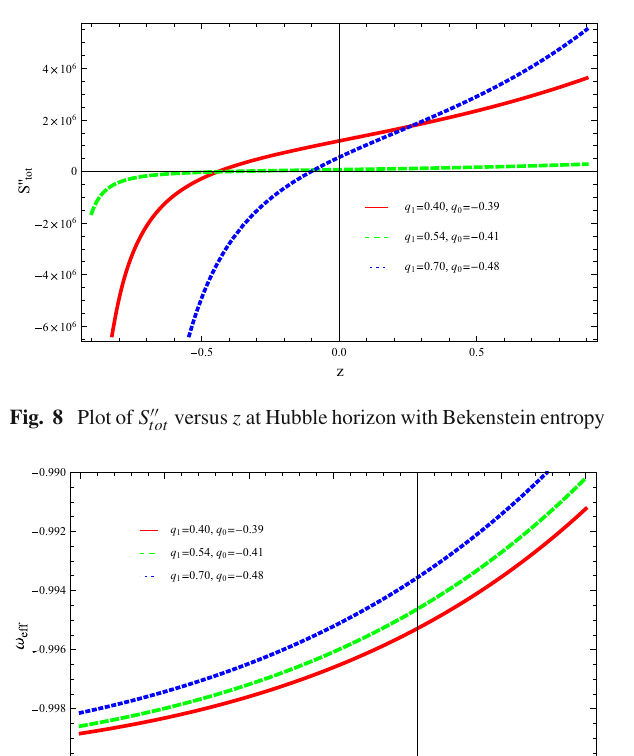
Fig. 7 Plot of S (cid:5) tot versus z at Hubble horizon with Bekenstein entropy